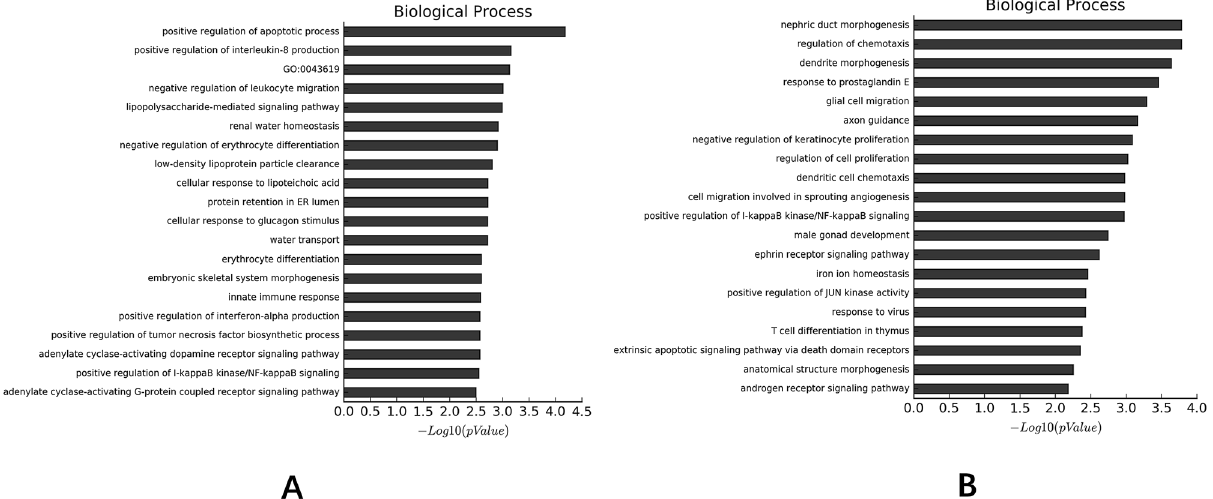
Figure 3. Go analysis. ( A ) Comparisons of differential DNA methylation sites between CD penetrating intestinal mucosal tissue with normal intestinal mucosal tissue; ( B ) Comparisons of differential DNA methylation sites between CD penetrating and non-penetrating intestinal mucosal tissue. GO data were downloaded from GO website (http:// geneo ntolo gy. org).